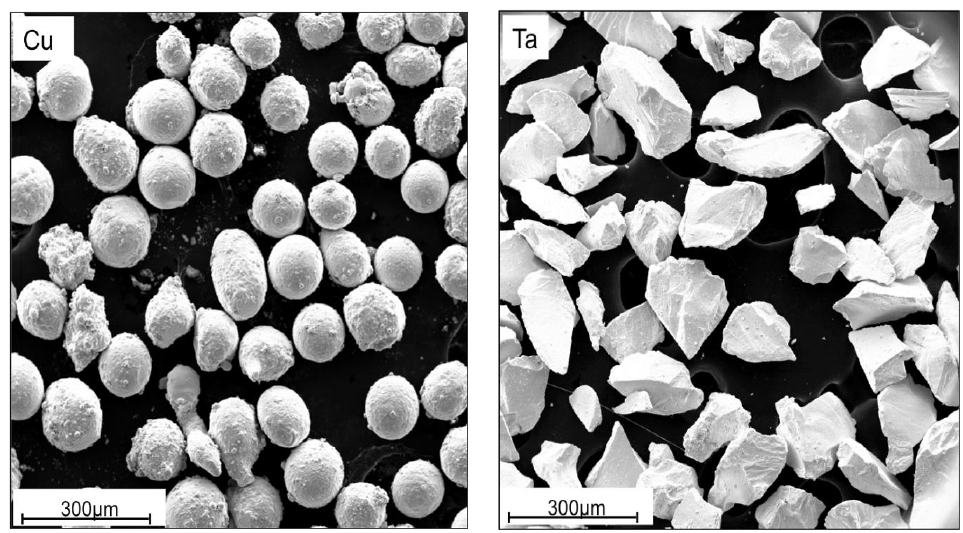
Figure 1. SEM micrographs of initial Cu ( left ) and Ta ( right ) powders used in consolidation. The Cu powder was sourced from Alfa Aesar (Haverhill, MA, USA). It is spherical with an average diameter of 126 μm ± 15 μm and an aspect ratio of 1.2 ± 0.2. Ta powder was provided by H.C. Stark (Goslar, DEU) and is HRC grade capacitor powder. The particles possess an average diameter of 153 μm ± 47 μm and aspect ratio of 1.8 ± 0.6. Cans used for extrusion were made of 304 stainless steel. Each can was approximately 178 mm long, with a cross section of 25 mm × 25 mm and included a circular center